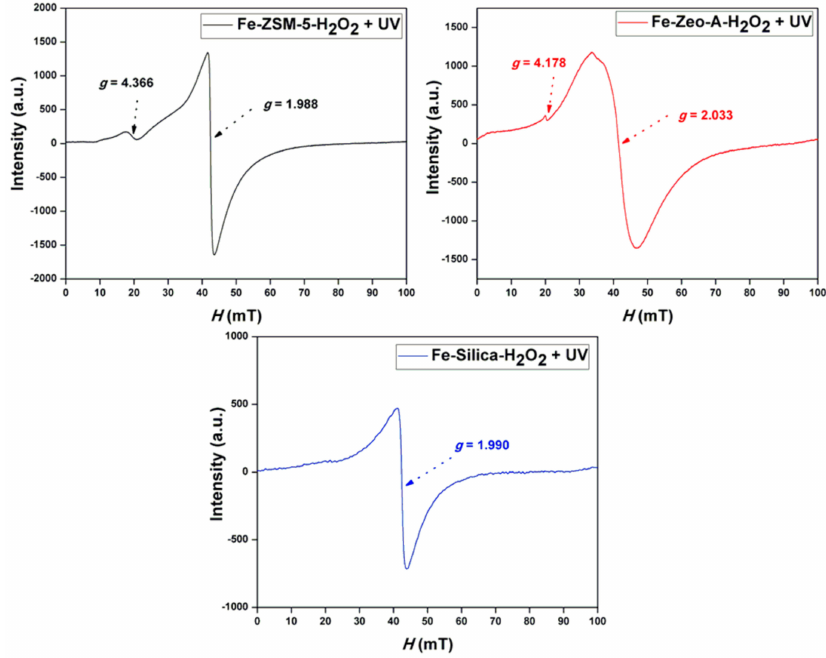
Figure 13. EPR spectra of Fe-ZSM-5, Fe-Zeo-A, and Fe-Silica after phenol degradation with UV + H 2 O 2